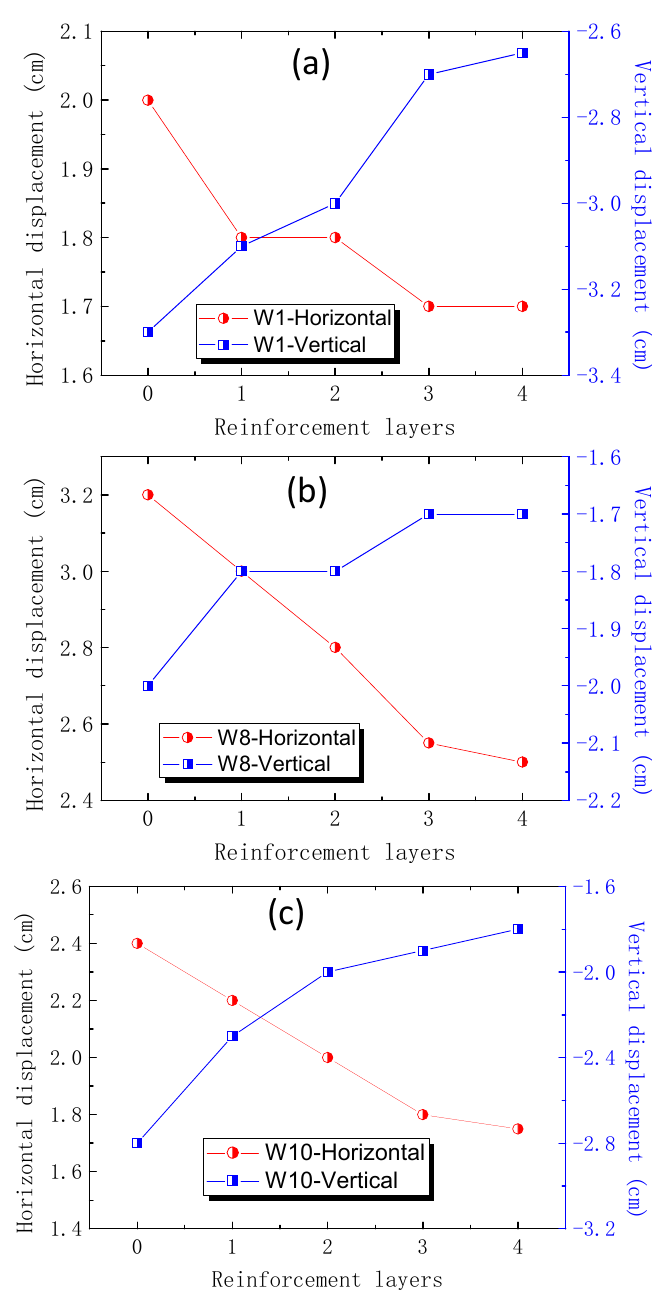
Figure 6. The final vertical and horizontal displacement of tracer points during overtopping for different reinforcement layers. ( a ) Displacement of point W1; ( b ) Displacement of point W8; ( c ) Displacement of point W10.